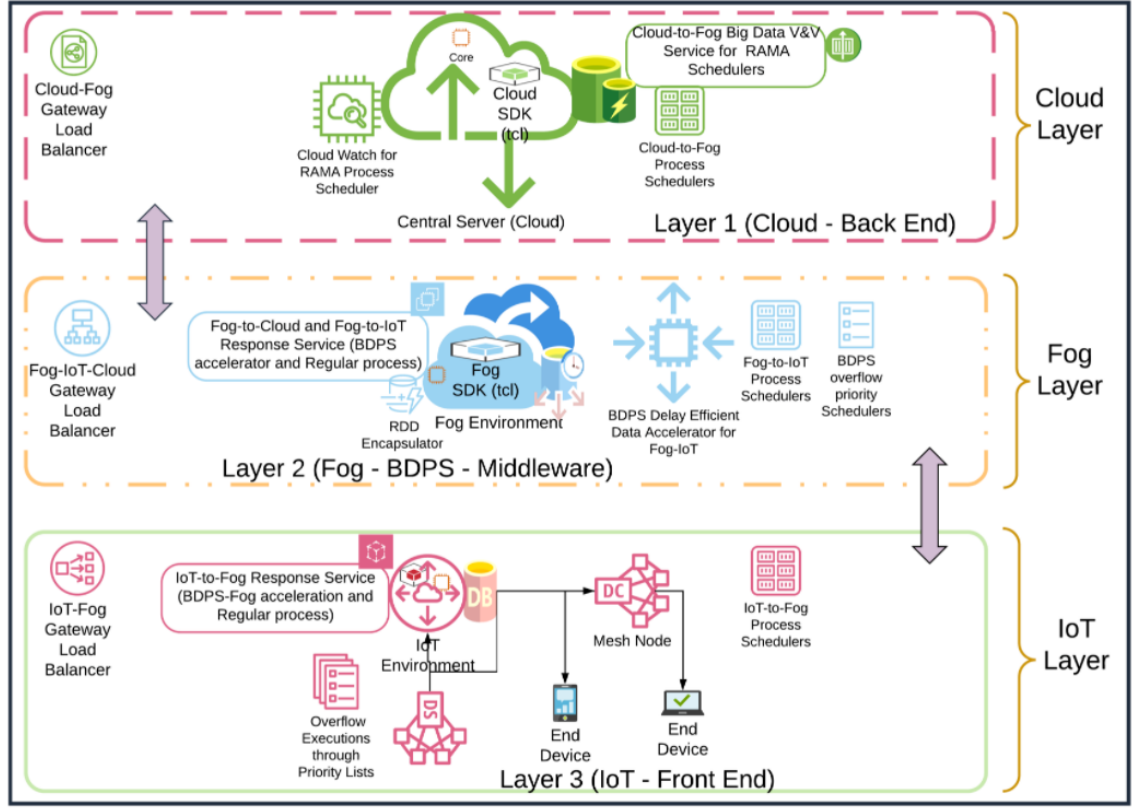
Figure 4. Overview of our developed BDPS